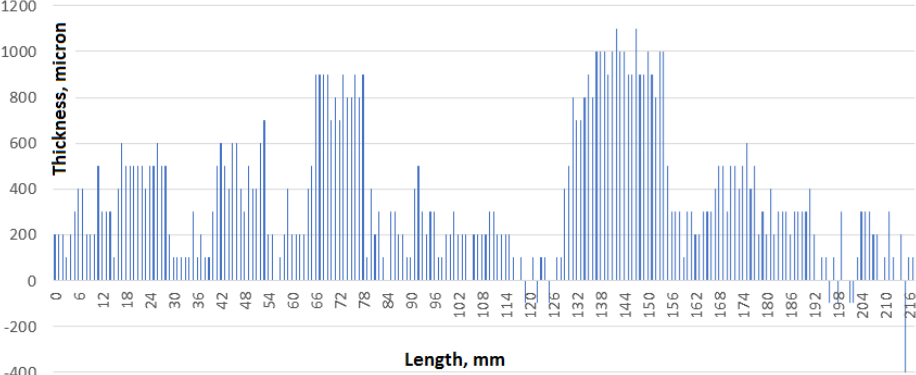
Figure 5. Graph of measuring the profile of the material measured thickness.